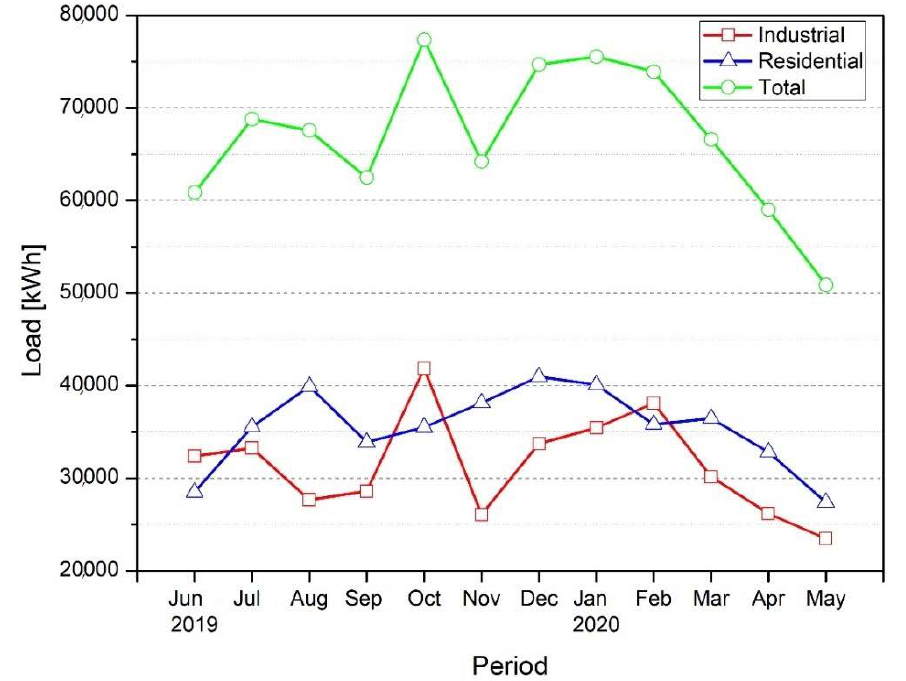
Figure 4. Average monthly power load of the residential area and industrial